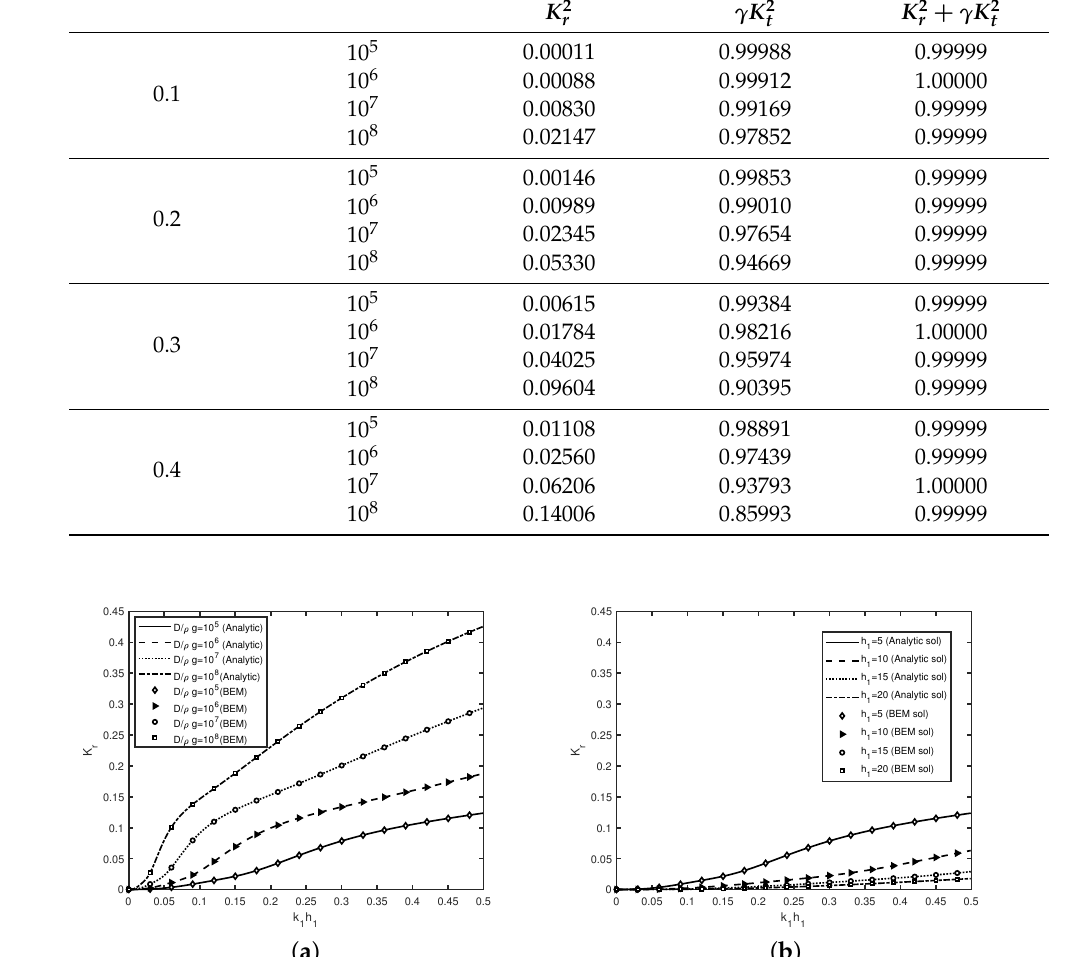
Figure 3. Semi-infinite plate for different values of ( a ) rigidity D / ρ g with h 1 = 5 m; ( b ) water depth h 1 with D / ρ g = 10 5 m 4 in the absence of